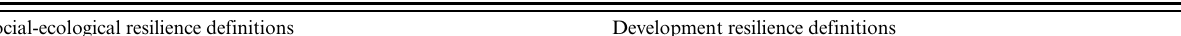
Table 1 . Definitions of resilience highlighted during the Resilience 2014 Conference: social-ecological system trend versus development perspective.